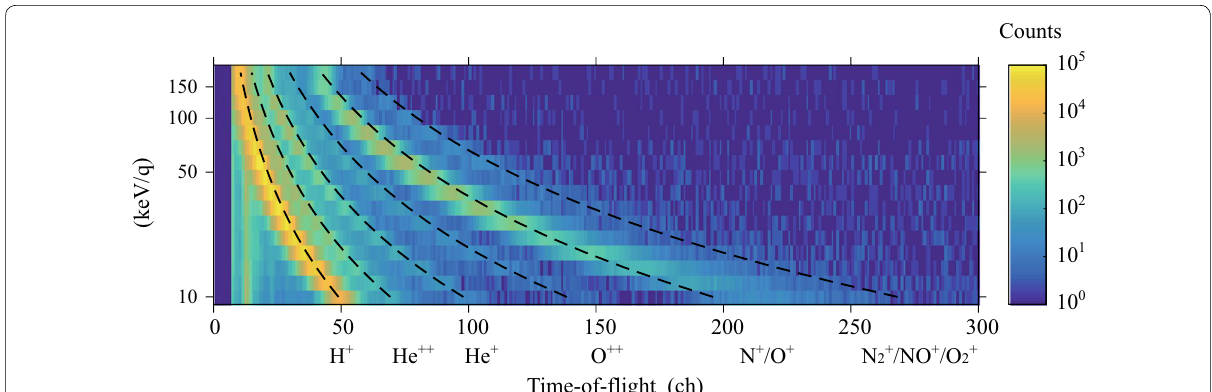
Fig. 12 TOF-energy/charge ( E/q ) profile of ions measured by the MEP-i on August 4, 2017. The dashed lines indicate the central TOF for H + ( m/q 1), He ++ ( m/q 2), He + ( m/q 4), O ++ ( m/q 8), N + /O + ( m/q 14–16), and N 2 + /NO + /O 2 + ( m/q = = = = = unit of the TOF channel corresponds to 0.78125 ns